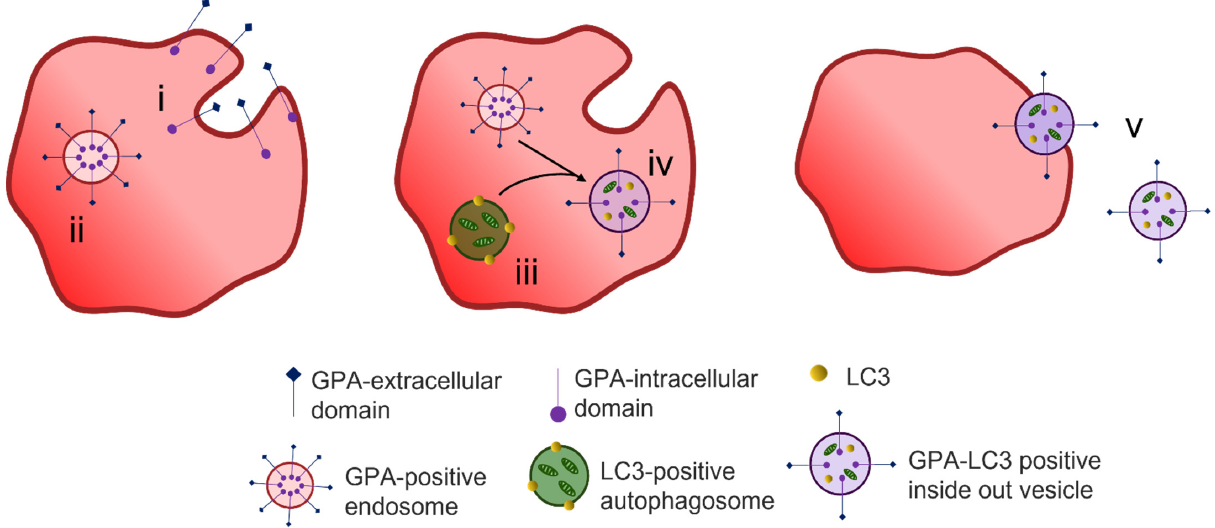
Figure 5. Reticulocyte maturation by expulsion of inside out hybrid vesicles. Endocytosis of superfluous membrane proteins occurs at the plasma membrane (i) during reticulocyte maturation forming GPA-positive endosomes (ii). LC3-positive autophagosomes are formed from isolated membranes that engulf cytoplasmic content including organelles (iii). The GPA-positive endosomes fuse with LC3-positive autophagosomes forming hybrid LC3-GPA positive inside out vesicles (iv) that are extruded during passage through the spleen (v). Figure modified from Mankelow et al. [94].